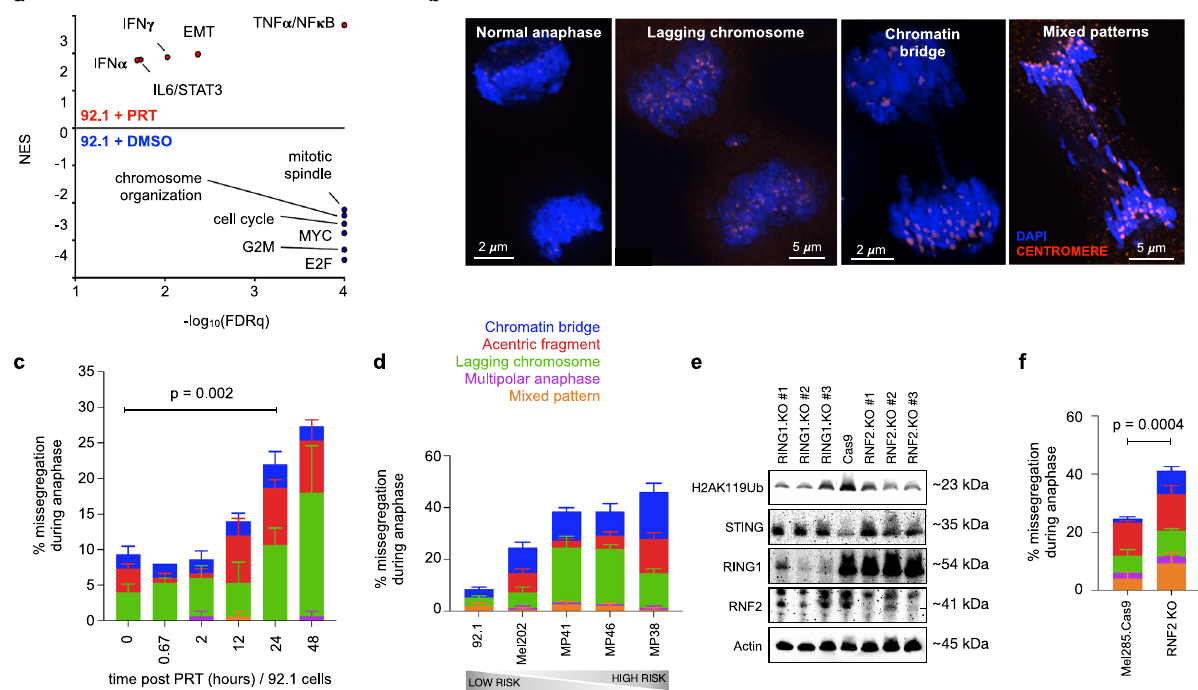
Fig. 5 Increased chromosome segregation errors upon PRC1 inhibition. a Volcano plots showing the top differentially expressed pathways in low-risk UM cells (92.1) treated with PRT vs DMSO for 24h; evaluated across biological triplicates. Normalized enrichment score (NES) for selected genesets shown as a function of signi fi cance, -log 10 (FDRq); FDRq, Bonferroni corrected p value. An un fi ltered list of all signi fi cant gene signatures is provided in Supplementary Data File 5. b Examples of UM cells in anaphase stained for DAPI (blue) and centromeres (red); demonstrating different patterns of chromosome segregation errors. Additional patterns of missegregation are shown in Supplementary Fig. 9b. Representative images from biological triplicates. c Abundance of chromosome segregation error patterns during anaphase in low-risk UM cells (92.1) upon PRT-treatment as a function of time. Statistical signi fi cance tested using two-sided unpaired Student ’ s t test. Source data are provided as a Source Data fi le. d Abundance of chromosome segregation error patterns during anaphase across UM cell lines, arranged from left to right based on their GEP2 score. Source data are provided as a Source Data fi le. e Western blot of H2AK119Ub, STING, RING1, and RNF2 relative to Actin in Mel285 cells upon RING1 and RNF2 knockout. Data representative of biological triplicates. f Abundance of chromosome segregation error patterns during anaphase in UM cells (Mel285.Cas9) upon RNF2 knockout. Statistical signi fi cance tested using two-sided unpaired Student ’ s t test. Source data are provided as a Source Data fi le. Stacked bars, mean of each missegregation pattern; error bars, standard error of the mean across experimental triplicates ( c – f ).